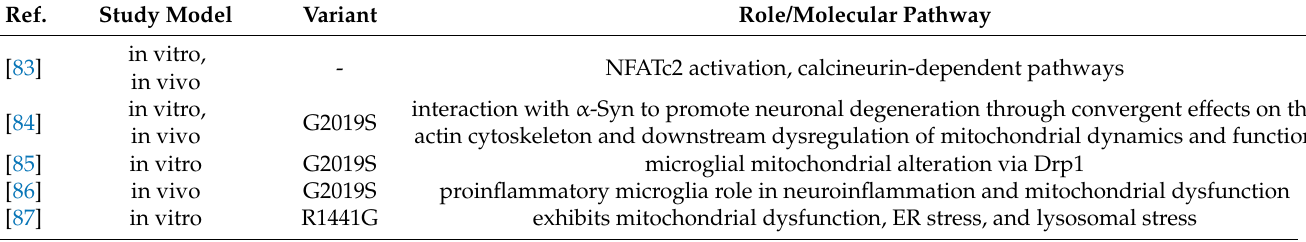
Table 13. LRRK2 and studies involving multiple